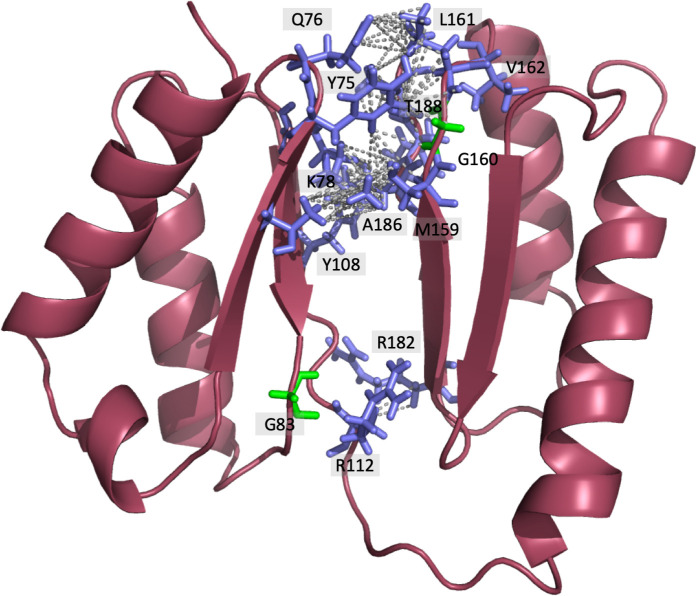
Representation of DolP interdomain interactions highlighting the location of interdomain NOEs identified.38 interdomain NOEs were identified via Cyana (Table 3). Due to the ambiguity between chemically equivalent hydrogens within the same group, multiple NOEs are displayed to all equivalent hydrogens resulting in 83 NOEs being displayed.